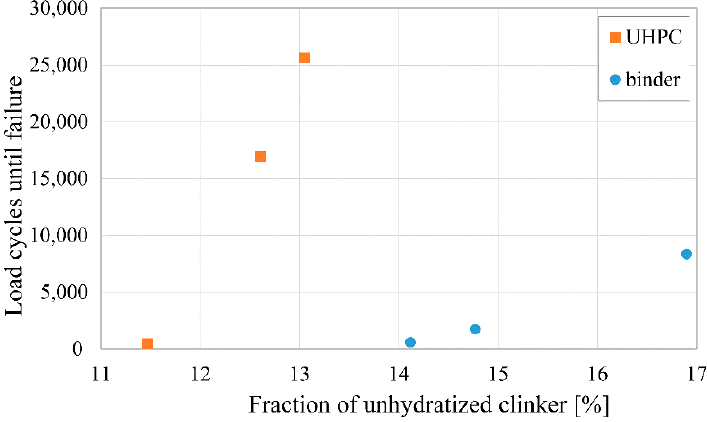
Figure 3. Graph of specimen lifetime vs. their relative content of unhydrated cement clinker showing a positive correlation.